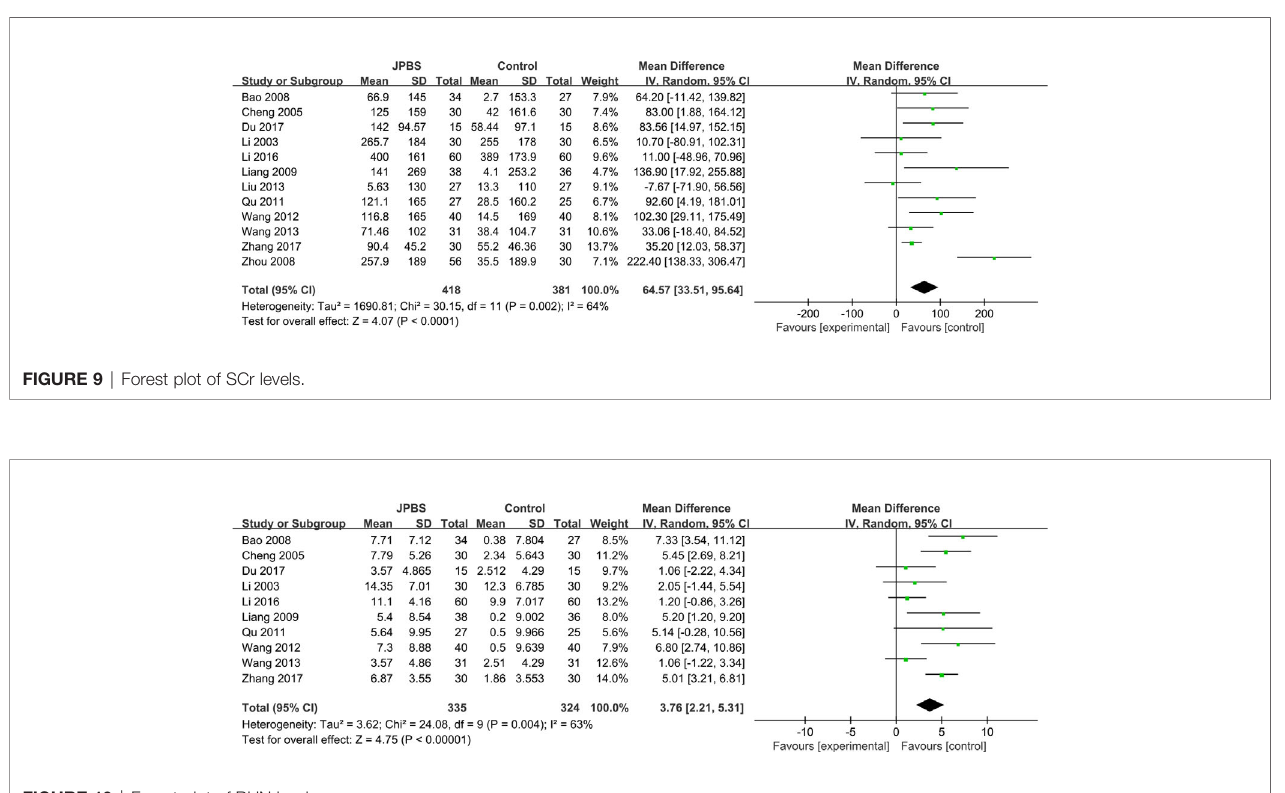
FIGURE 10 | Forest plot of BUN levels.